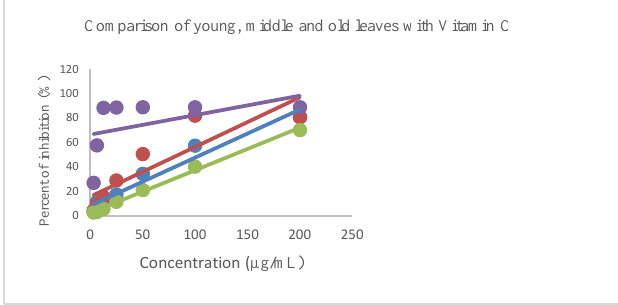
Figure 2: DPPH radical scavenging activity of the methanolic extracts of young leaves, middle-age leaves and matured leaves compared with vitamin C as positive